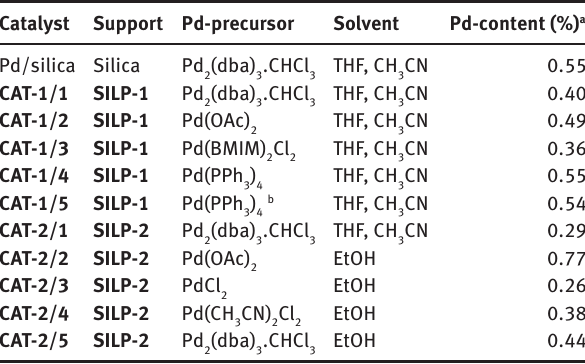
Table 1: Supported palladium catalysts used during the carbonylation reactions.